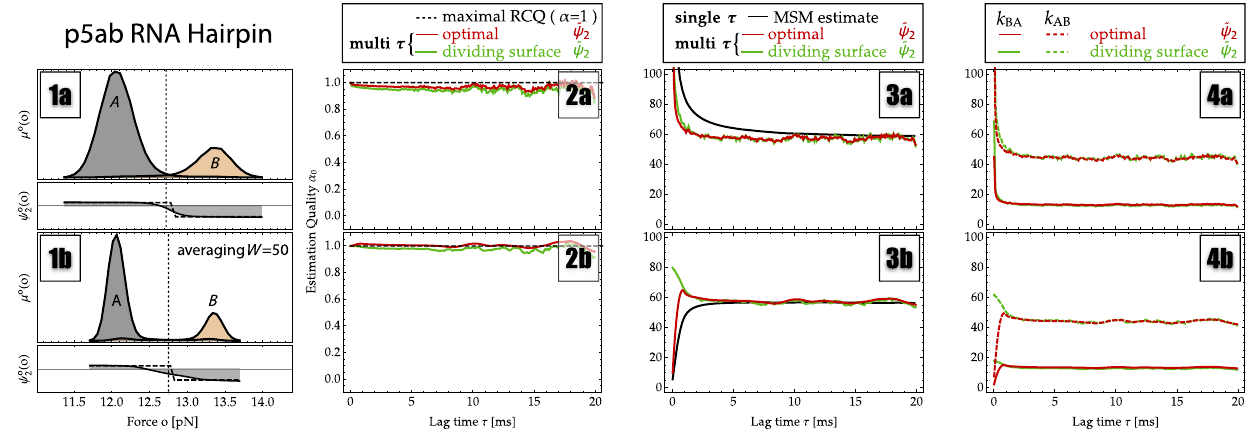
FIG. 4. Estimates for rates and estimation qualities from passive-mode single-molecule force-probe experiments of the p5ab RNA hairpin. All panels report the estimation results, showing the direct MSM estimate (black line), a fit to the fluctuation autocorrelation function using a dividing surface at o ¼ 12 : 80 pN (green line), and spectral estimation (red line). (1a),(1b) The stationary probability of observing a given force value (solid black line). The partial probabilities of states A (gray) and B (orange) obtained by spectral estimation show that there is very little overlap between the states. (2a),(2b) The estimation quality α o , coinciding with the OQ ˆ α o for spectral estimation. (3a),(3b) Estimated relaxation rate κ 2 . (4a),(4b) Estimated microscopic transition rates: the folding rate k AB (dashed line) and the unfolding rate k BA (solid